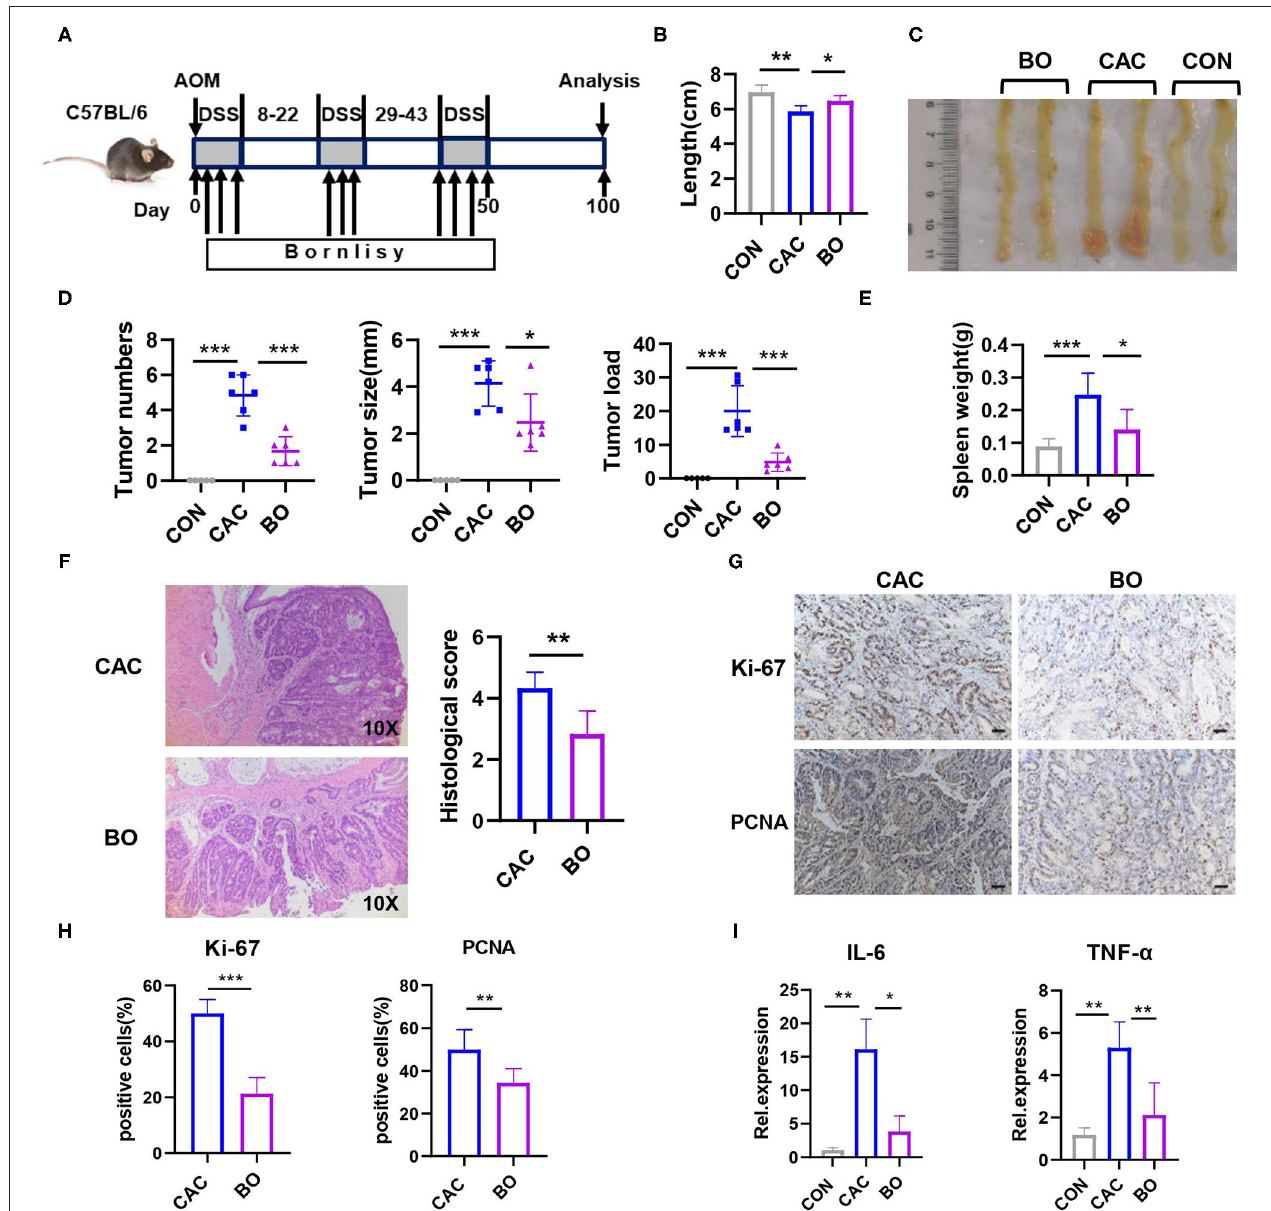
FIGURE 2 | Bornlisy treatment protects the mice from colitis-associated colon cancer (CAC). (A) C57BL/6J mice ( n = 5 for each group) were injected intraperitoneally with azoxymethane (AOM) (10 mg/kg) on day 1, 2% dextran sodium sulfate (DSS) was subsequently added to the drinking water for 7 consecutive days. Three cycles of DSS treatment were used. The mice were orally inoculated with BO (10 ml/kg) once every 2 days during the DSS treatment. After induction of tumorigenesis (100 days), the mice were euthanized. The spleens and colons were removed. (B) Colon length was measured. (C) The representative images of colon tumors were shown. (D) Tumor number, tumor size, and tumor load in the colons were measured. (E) The spleens from mice were weighted. (F) The histological analysis of colon tumors was shown by H&E staining. The histological score was assessed by a pathologist (scale bars, 50 µ m). (G) Tumor tissues were stained for Ki-67 and proliferating cell nuclear antigen (PCNA) (scale bars, 50 µ m). (H) The percentages of Ki-67-positive and PCNA-positive tumor cells were quantified. (I) mRNA expressions of IL-6 and TNF- α in tumors were detected using quantitative real-time PCR (qPCR). Data with error bars are represented as mean ± SD. Each panel is a representative experiment of at least three independent biological replicates. * p < 0.05, ** p < 0.01, and *** p < 0.001 as determined by unpaired Student’s t